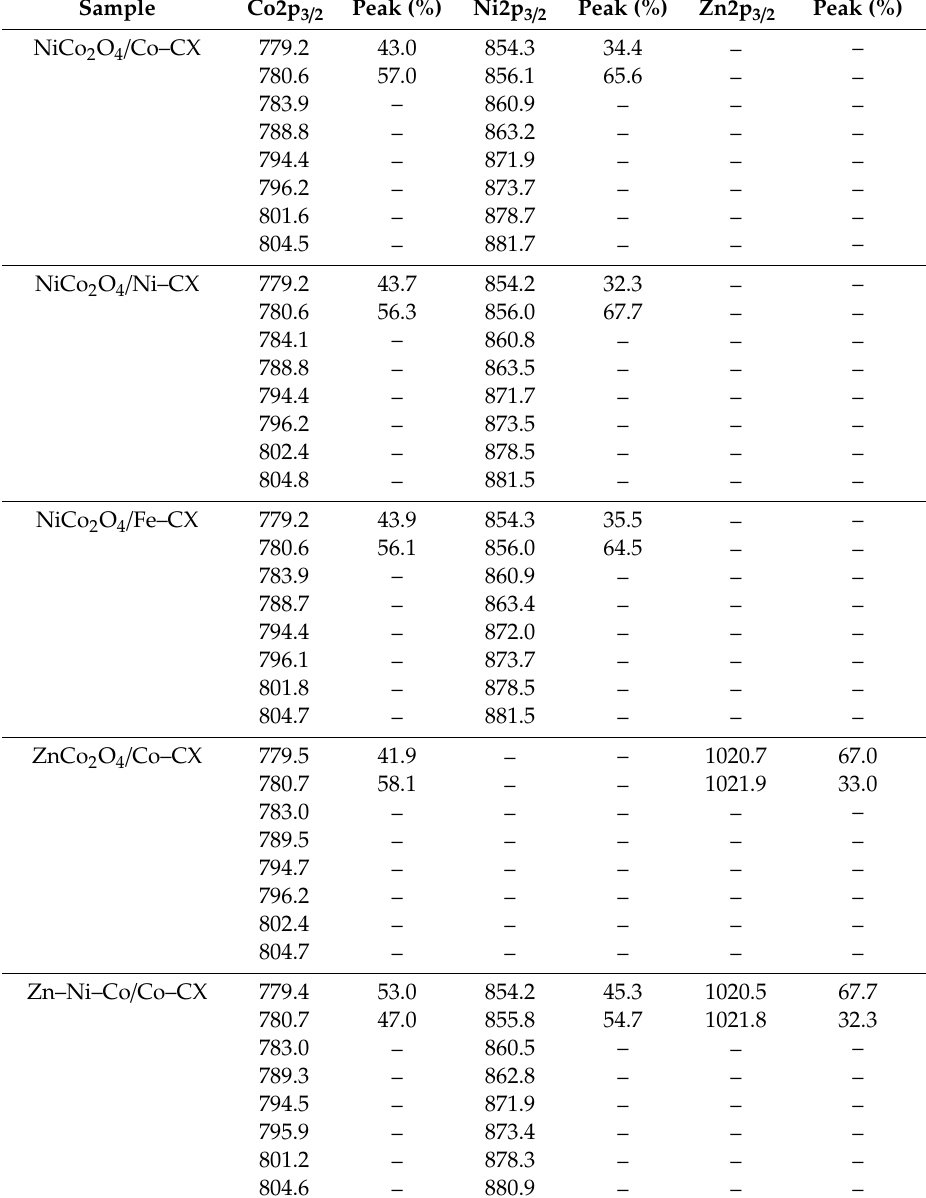
Table 4. Binding energies (eV) of Co2p, Ni2p, and Zn2p regions.